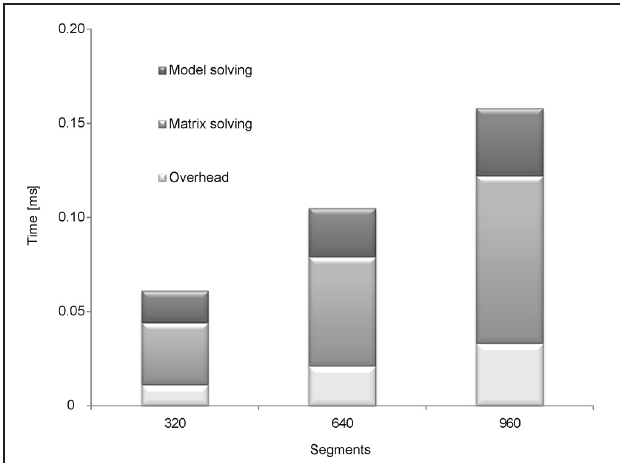
FIGURE 3 | Analyzing the runtime of matrix and model solving. Four different simulations were used to analyze the runtime of model solving and solving the equation system (matrix): 1, full simulation; 2, simulation with a passive model; 3, simulation without solving the matrix (Hodgkin–Huxley model); 4, simulation with a passive model and without solving the matrix. To calculate the runtime of matrix solving the runtime of simulation with a passive model was subtracted from the full simulation. To calculate the runtime of model solving the runtime of simulation without matrix solving was subtracted from full simulation. The simulations were ran on fork morphologies with 320, 640, and 960 segments.